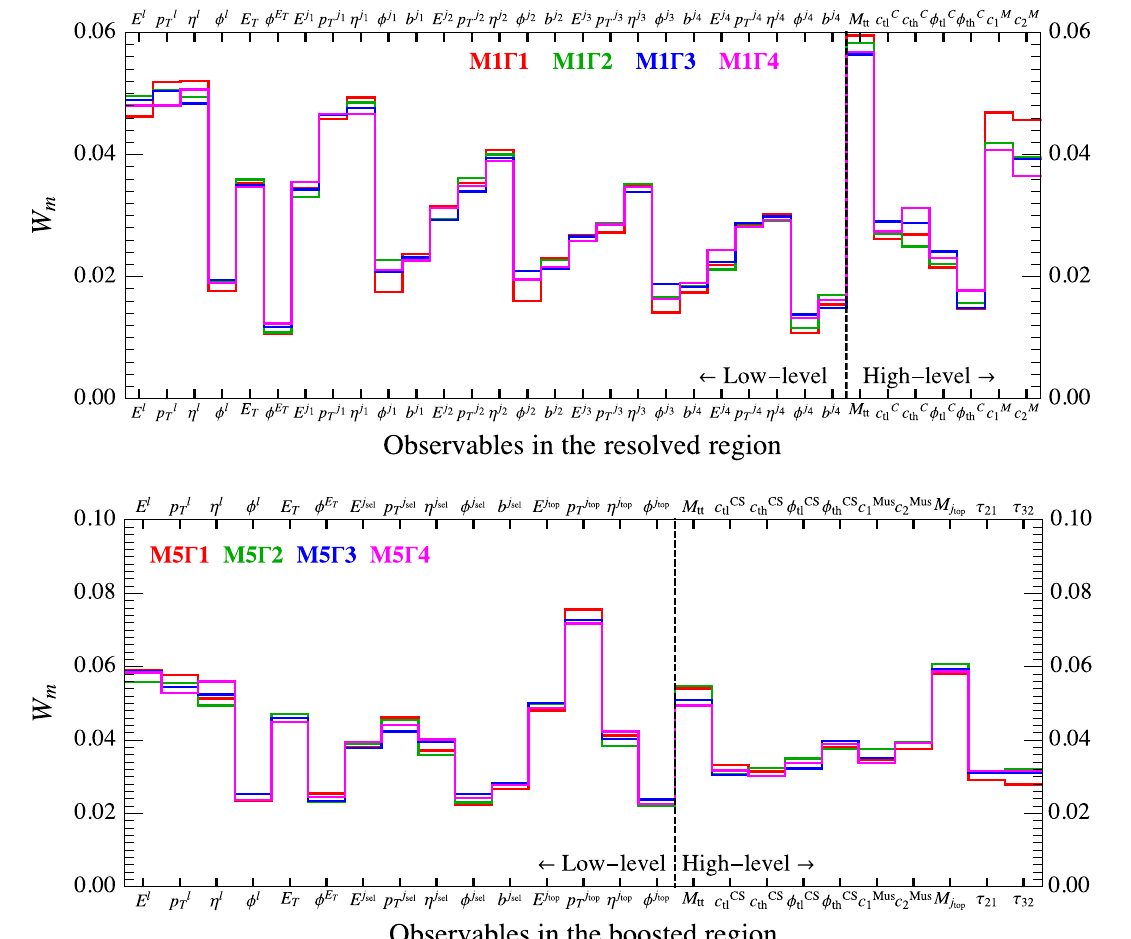
Fig. 6 The weight of each observable in the first layer of DNN, W m defined in Eq. (10). M ρ = 1 TeV in the resolved region (upper panel) and M ρ = 5TeVintheboostedregion(lowerpanel).High-levelobserv-